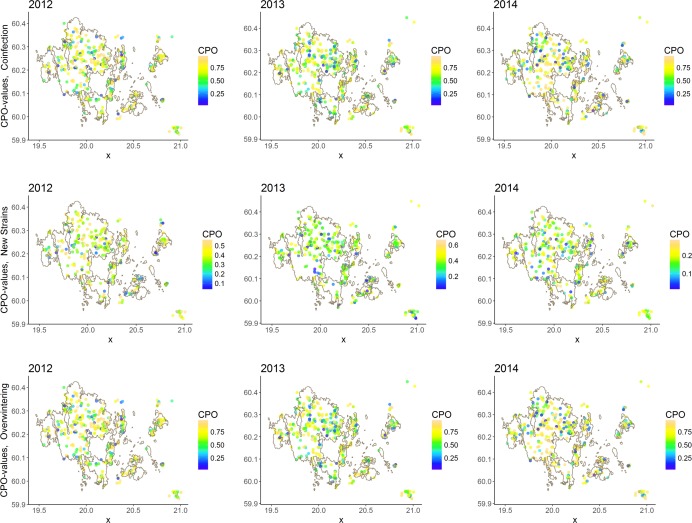
CPO-values distributed in space.The CPO-values for the three models exhibit no particular spatial patterns, providing a further model validation argument.